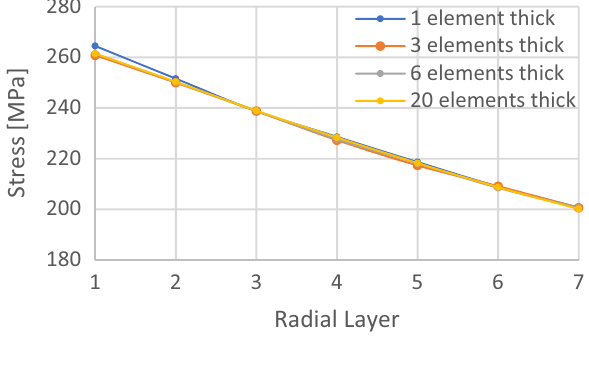
Fig. 5 Mesh sensitivity